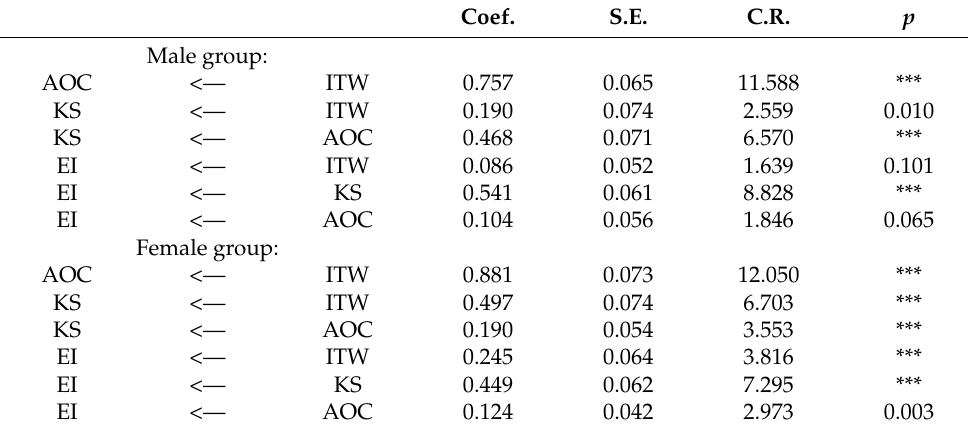
Table 5. Results from the unrestricted multi-group structural equation